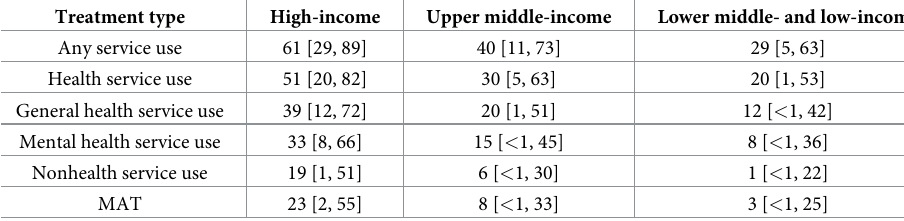
Table 5. Predicted percentage of MDD cases receiving treatment [95% UI] by income group.